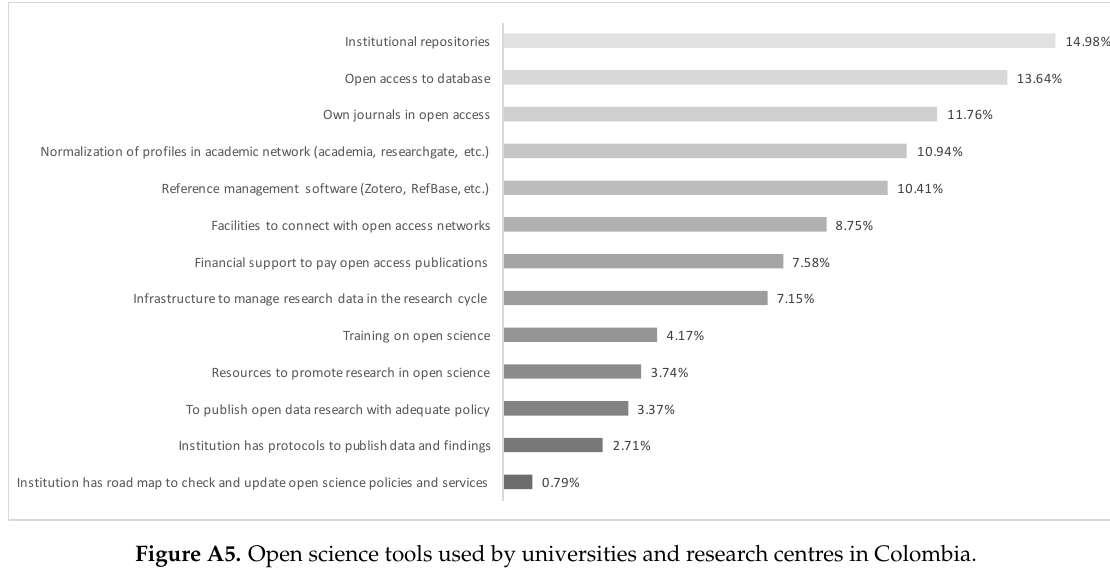
Figure A4. Open science tools used by Colombian researchers, according to the survey results.